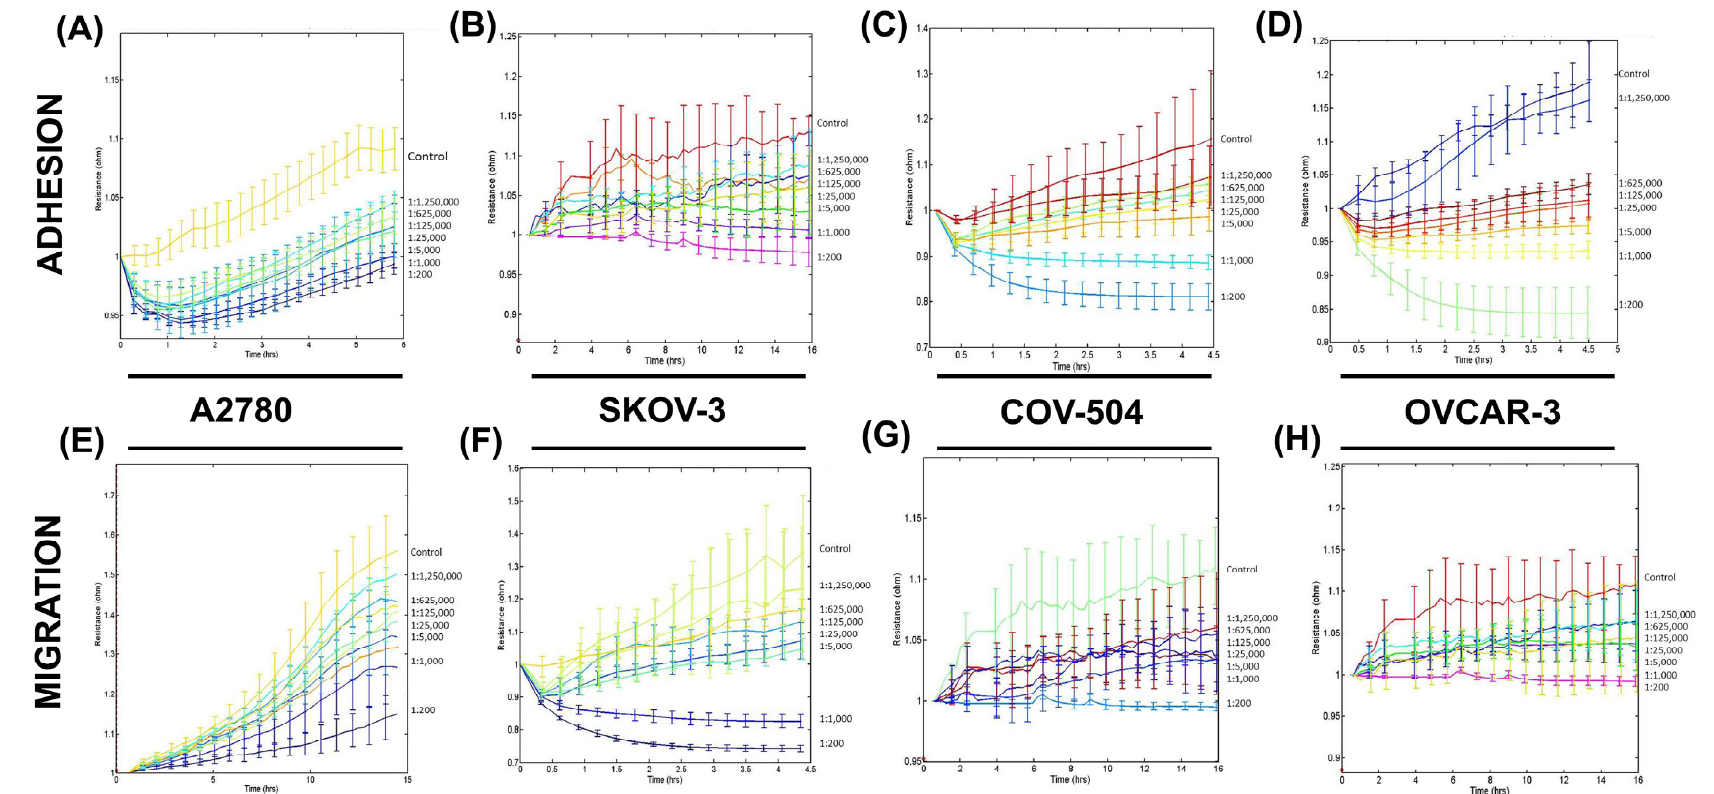
Figure 2. Concentration-dependent inhibition by SLDM on the adhesion and migration of ovarian cancer cell lines cells. Increasing concentrations, ranging from 1:200 to 1:1,250,000, of SLDM resulted in significantly reduced cell attachment of all four of the ovarian cell lines tested ( A ): A2780; ( B ): SKOV-3; ( C ): COV-504; ( D ): OVCAR-3. A similar trend in all of the ovarian cell migration responses after treatment with SLDM ; ( E ): A2780; ( F ): SKOV-3; ( G ): COV-504; ( H ): OVCAR ‐ 3.